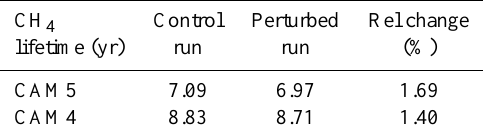
Table 2. Global annual average CH 4 lifetimes against reaction with OH, as calculated by CAM4 and CAM5 for the control run and for the NO x perturbation run. The relative change between runs is displayed in the right-most column. It is noted that the calculated lifetimes are shorter than the CH 4 lifetime derived based on Methyl chloroform analysis (Prather et al.,